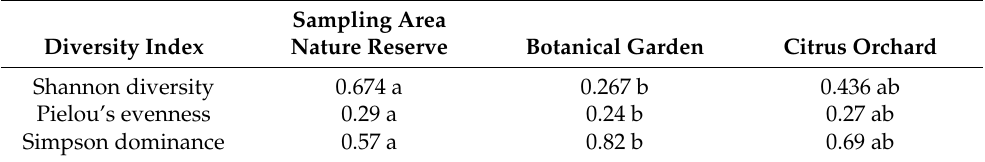
Table 2. Comparison of diversity indices of the Phytophthora community in DNA metabarcoding rhizosphere soil-positive samples from the three surveyed areas. Data were analyzed with the Kruskal–Wallis